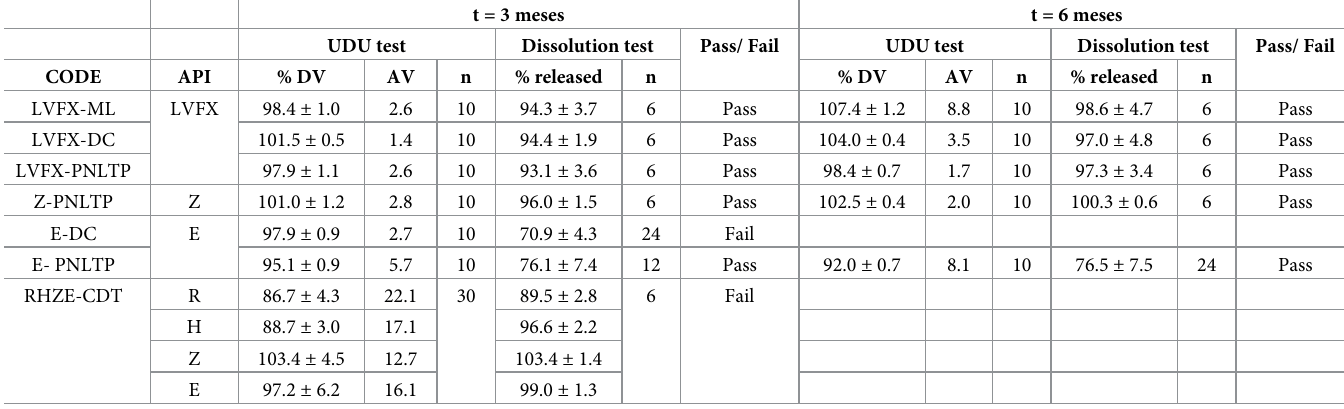
Table 5. Results of uniformity of dosage units and dissolution test during stability study. API: Active Pharmaceutical